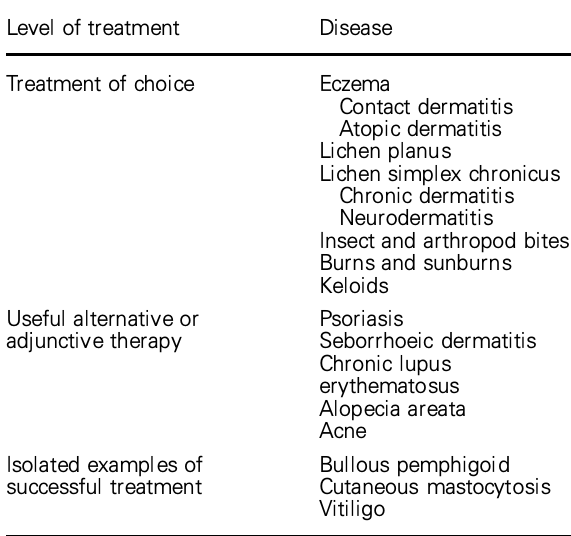
Table 2. Inflammatory dermal diseases treated with topical